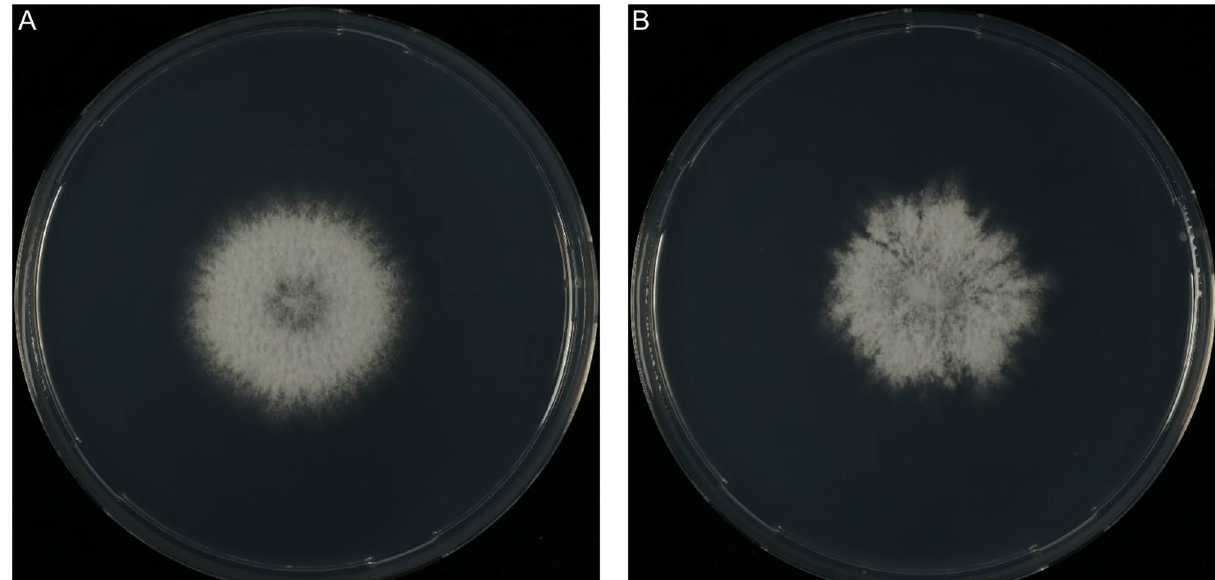
Figure 2. Monokaryotic ( A ) and dikaryotic ( B ) growth of S. commune H4-8A after 90 h. The monokaryon grows symmetrically, while the dikaryon is asymmetric and develops hyphal aggregates (the first stage of mushroom development) at the edge of the colony.